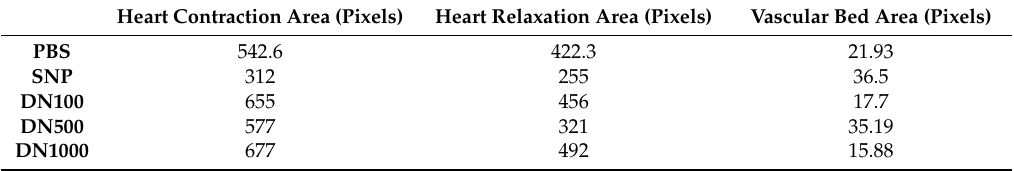
Table 3. Measurements of heart functions related